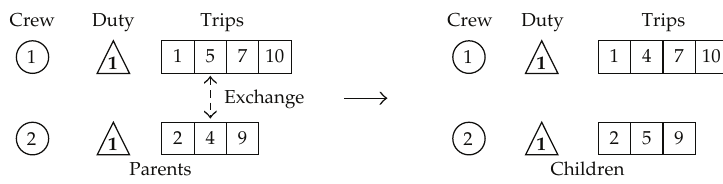
Figure 4: Trips exchange